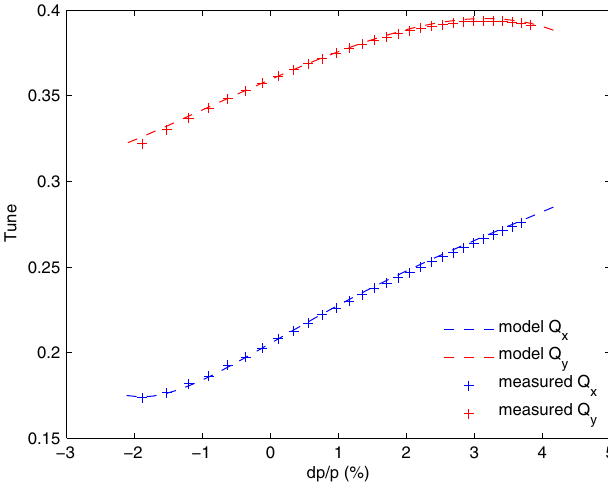
FIG. 3. Frequency map obtained after fitting only the sextupole gradients. See text for explanation. The color code corresponds to the diffusion coefficient of the betatron tunes, with dark blue indicating the most stable trajectories.